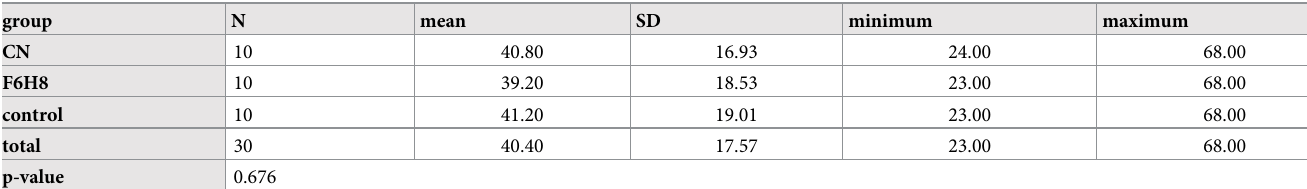
Table 2. Age distribution (short term analysis group).